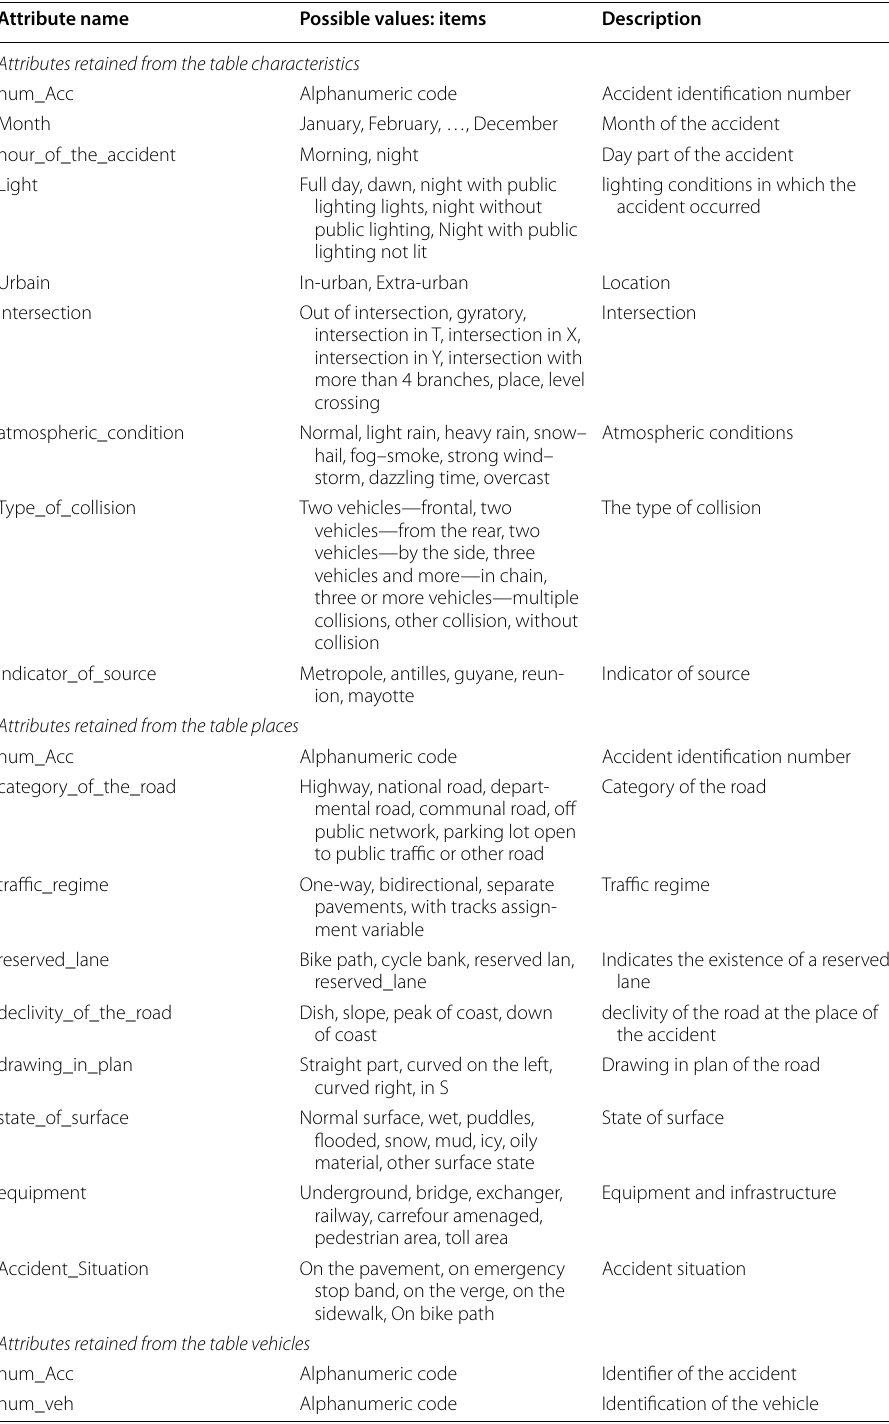
Table 1 Attributes retained for the description of